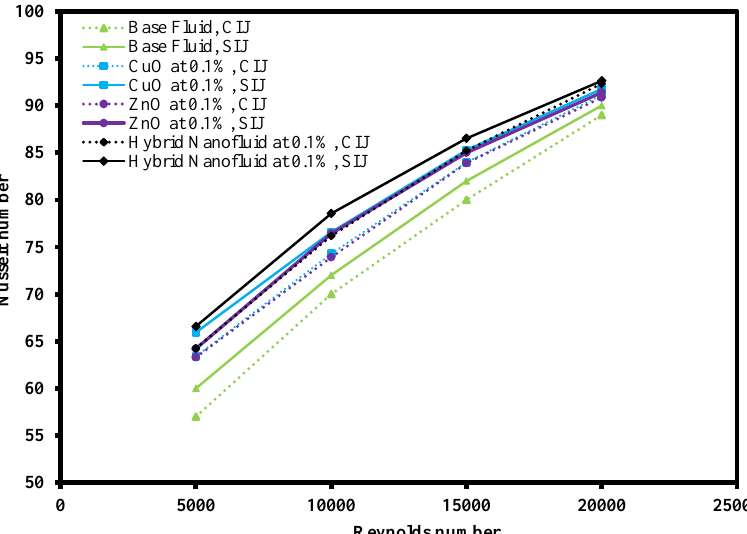
Figure 14. Result of Nusselt number vs. Reynold number for hybrid nanofluid, mono-nanofluids, and base fluids under CIJ and SIJ.